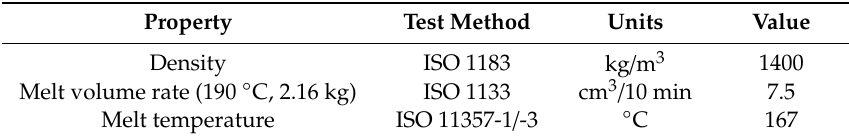
Table 2. Main properties of the material.